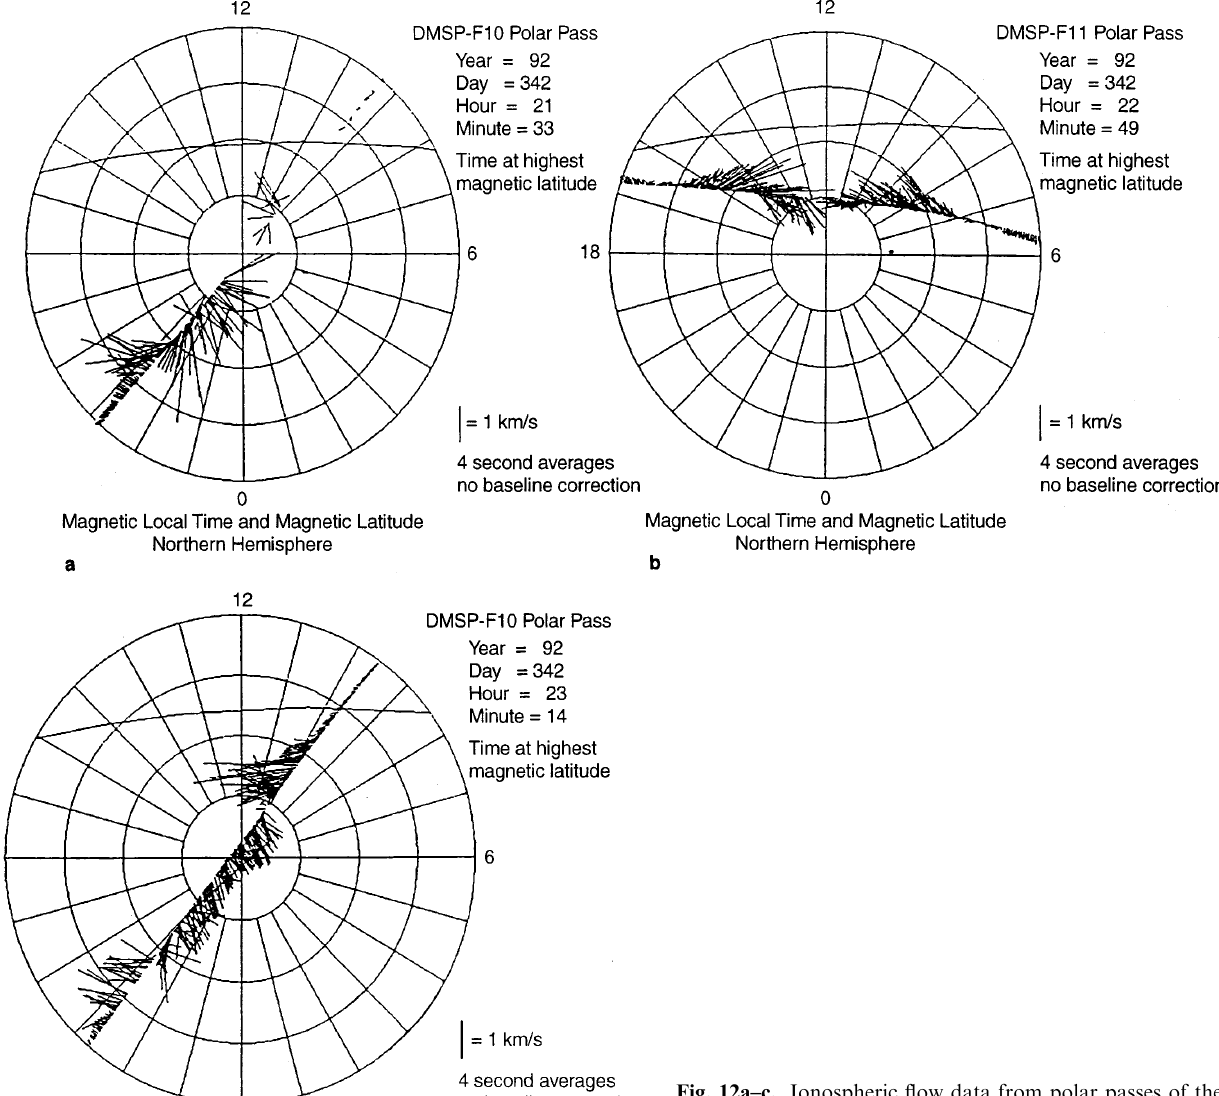
Fig. 12a–c. Ionospheric flow data from polar passes of the DMSP satellites F10 and F11 for the period 2133–2314 UT, 7 December, 1992. The plots are for Northern Hemisphere passes and are arranged in chronological order regardless of which satellite